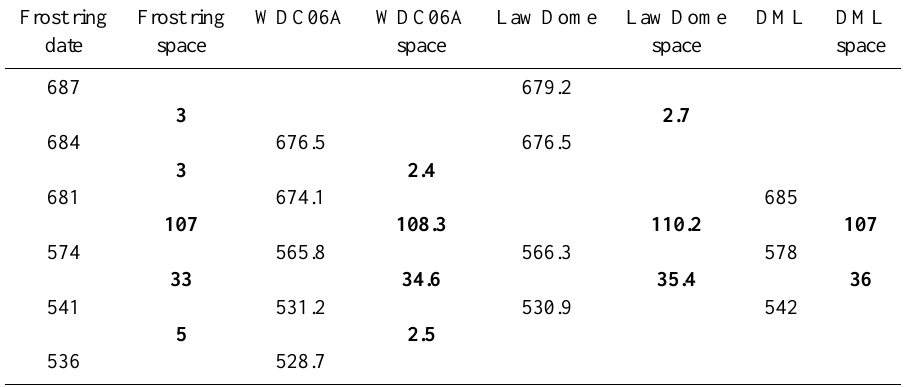
Table 3. Intervals between bristlecone pine frost rings (Salzer and Hughes, 2007) and intervals between acid start dates in three Antarctica ice cores; WDC06A (Sigl et al., 2013), Law Dome (Plummer et al., 2012) and DML (Traufetter et al., 2004). For clarity the value of the interval in each record is marked in bold. The consistent spacing suggests that the ice dates should be moved to conform to the tree ring